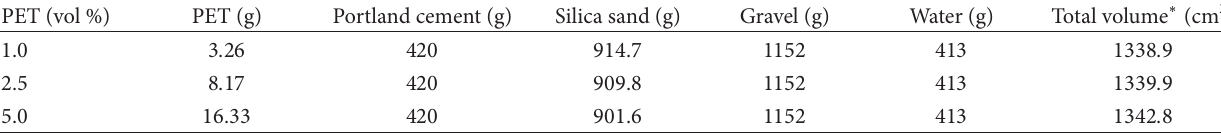
Table 3: Components of concrete with recycled PET.